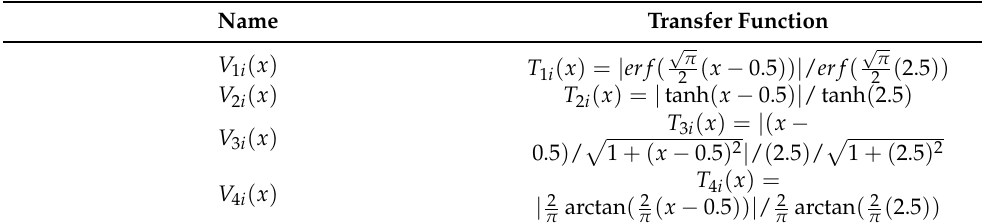
Table 7. The expressions of the improved V-shaped transfer functions.